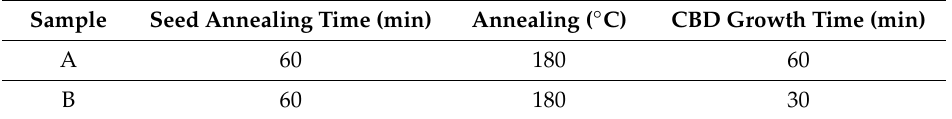
Table 2. Processing conditions used for PES / ZnO mats to study ZnO coverage uniformity by TGA.